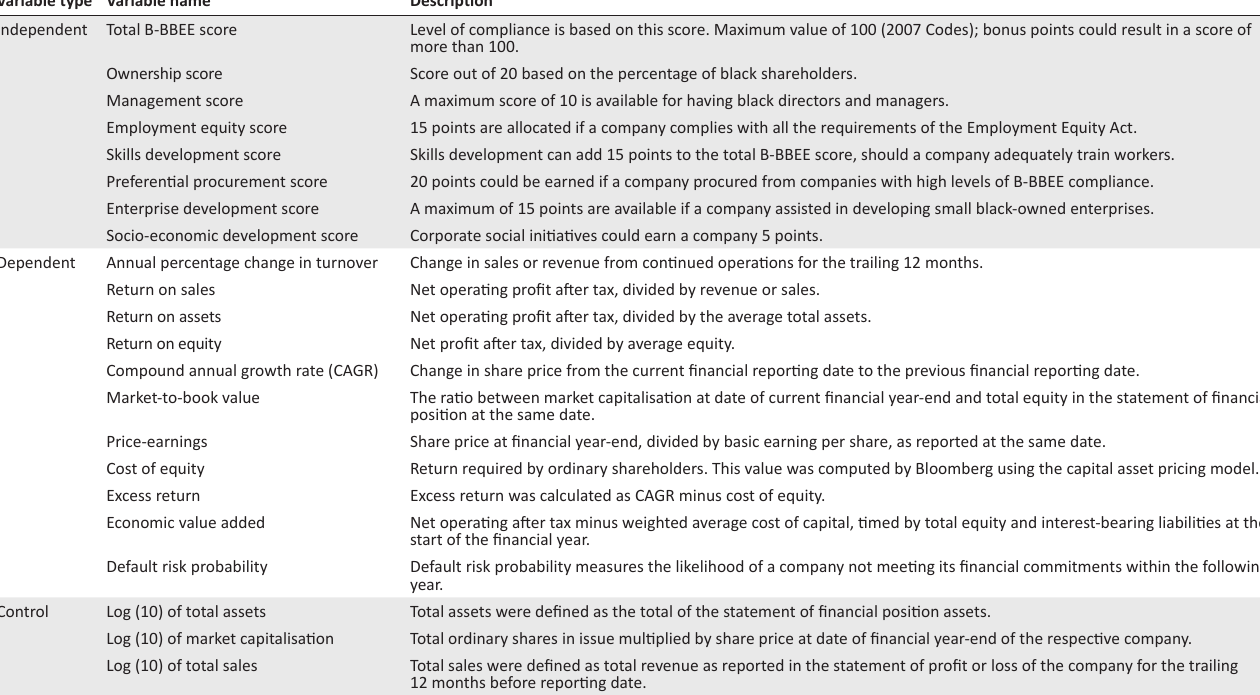
TABLE 4: Operationalisation of the variables.